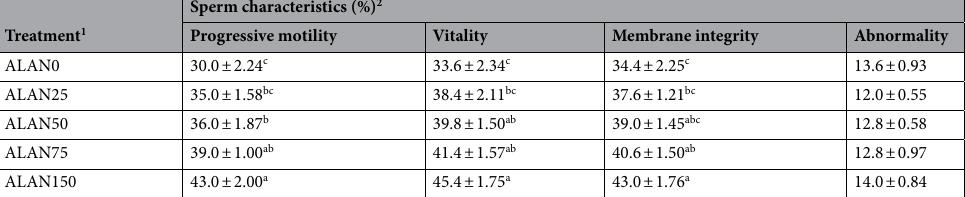
Table 4. Effect of supplementing Tris-extender with alpha-lipoic acid loaded liposomes (ALAN) on sperm characteristics (%) in post-thawed buffalo bull semen after incubation (at 37 °C and 5% CO 2 for 2 h). 1 Tris extender supplemented with different levels of alpha-lipoic acid loaded liposomes (ALAN) containing 0 (ALAN0), 25 (ALAN25), 50 (ALAN50), 75 ALAN75 and 150 ALAN150 (0, 25, 50, 75 and 150 µg/mL), respectively. 2 a–c means denoted within the same column with different superscripts are significantly different at P <